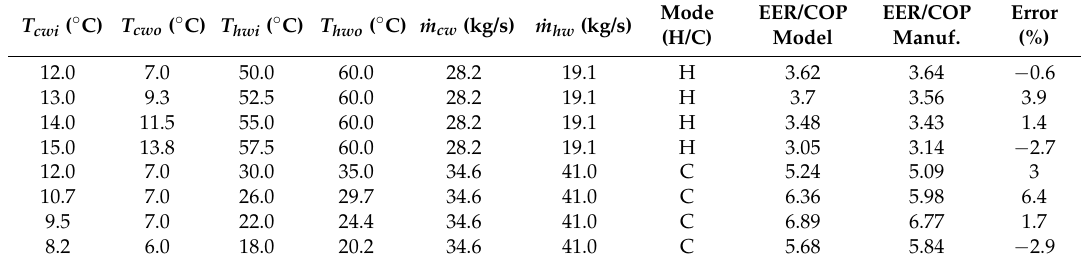
Table A1. Model results and manufacturer’s data in heating mode (H) and cooling mode (C).